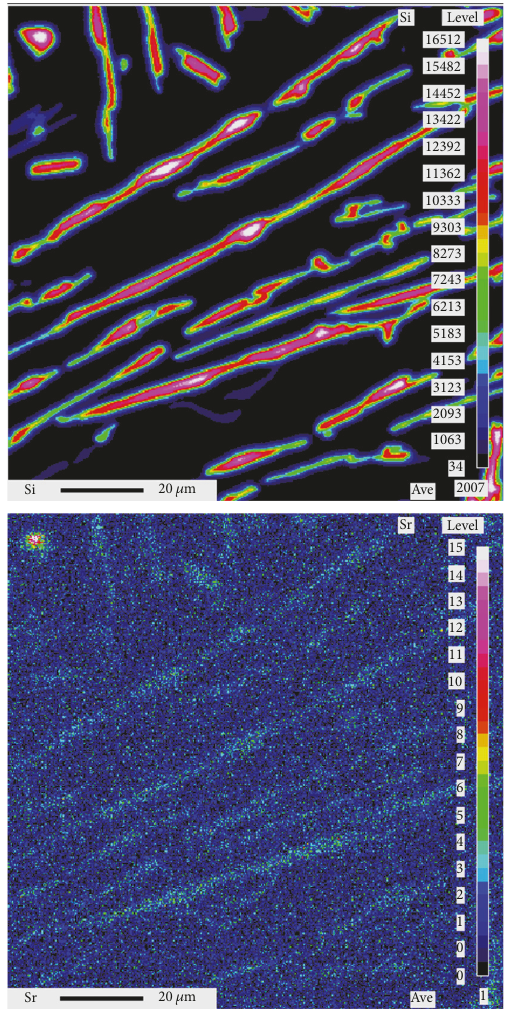
Figure 10: Distribution of Sr in the modified A356